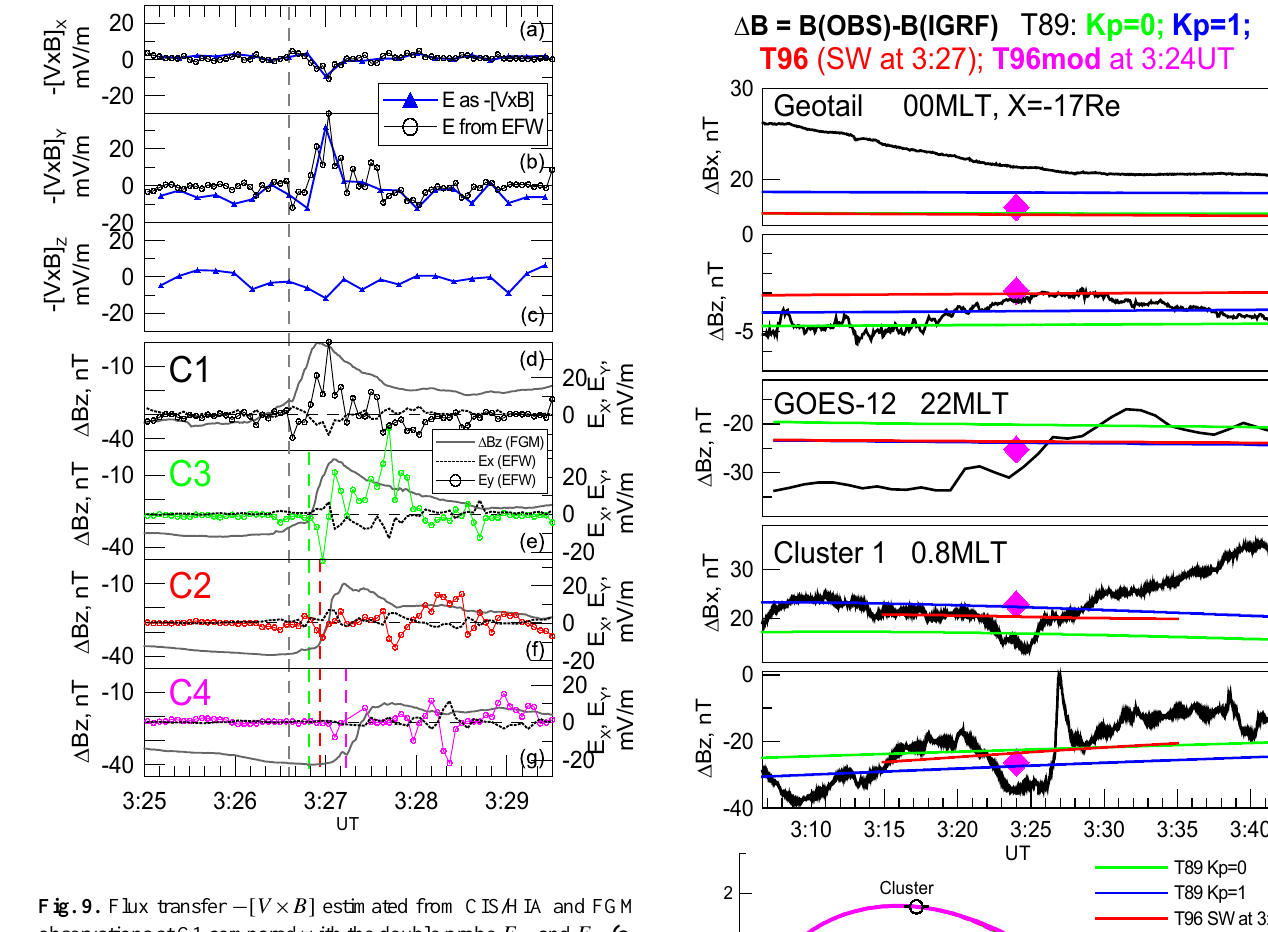
Fig. 9. Flux transfer −[ V × B ] estimated from CIS/HIA and FGM observations at C1 compared with the double probe E X and E Y (a– c) ; EFW E X (dashed) and E Y electric field, together with FGM B Z variations at four Cluster spacecraft (d–g) .